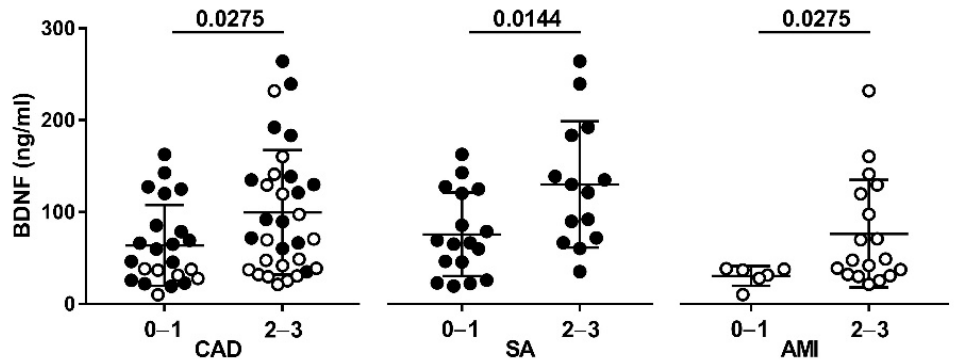
Figure 2. Plasma BDNF levels in CAD patients with diagnosis of SA and AMI in relation to plaque vulnerability core. Plasma BDNF levels were analyzed in relation with low (group 0–1) or high (group 2–3) risk of plaque vulnerability. OCT features of plaque vulnerability were the presence of TCFA, lipid plaque and/or MØI. Data are expressed as mean ± SEM. Higher BDNF levels were found in patients with lipid plaque than in those without ( p = 0.007) and in patients with MØI than in those without ( p = 0.030) (Table 2) In particular, after adjustment for prior cardiovascular treatment and risk factors, the difference between patients with and without lipid plaque ( p < 0.005) as well as between patients with and without MØI ( p < 0.037) was maintained. Table 2. Plasma BDNF levels according to OCT features in CAD